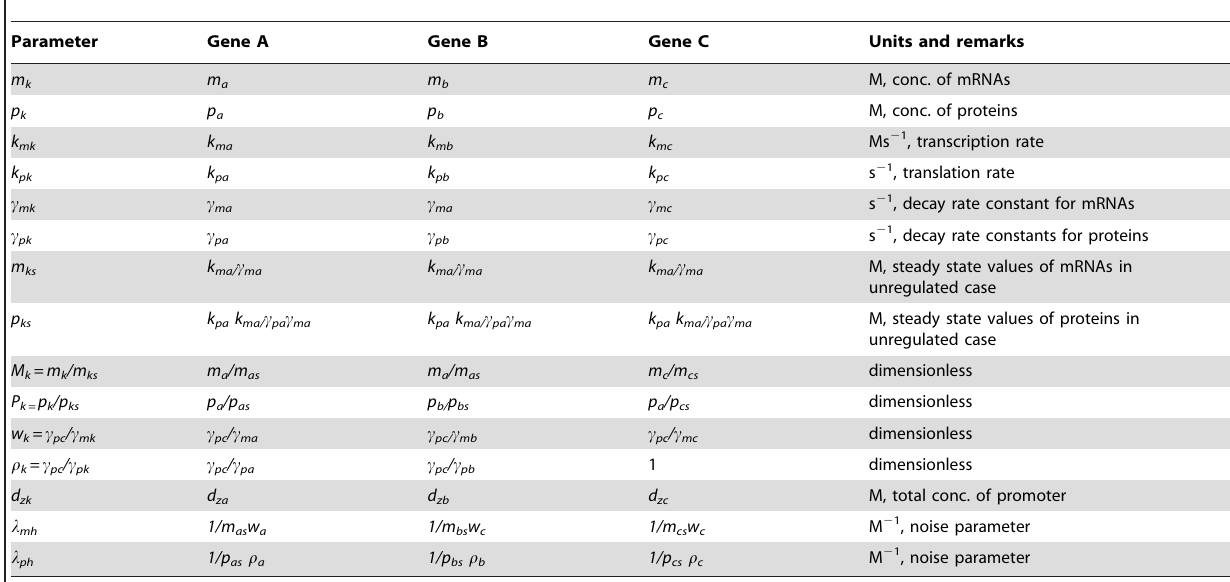
Table 1. Definition of parameters used to describe the dynamics of various FFLs.